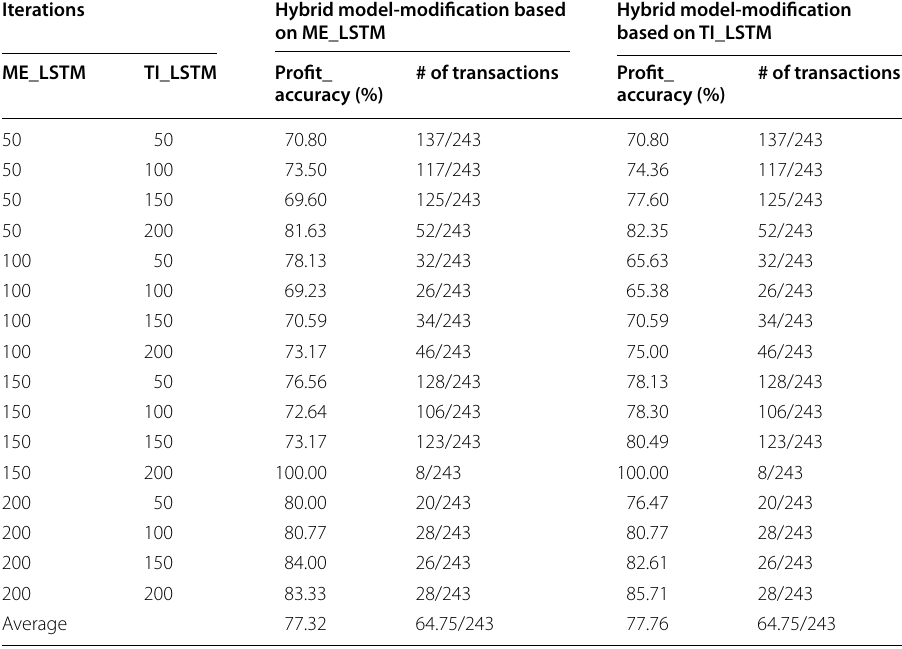
Table 7 Hybrid model: one‑day‑ahead predictions Iterations Hybrid model‑modification based on ME_LSTM